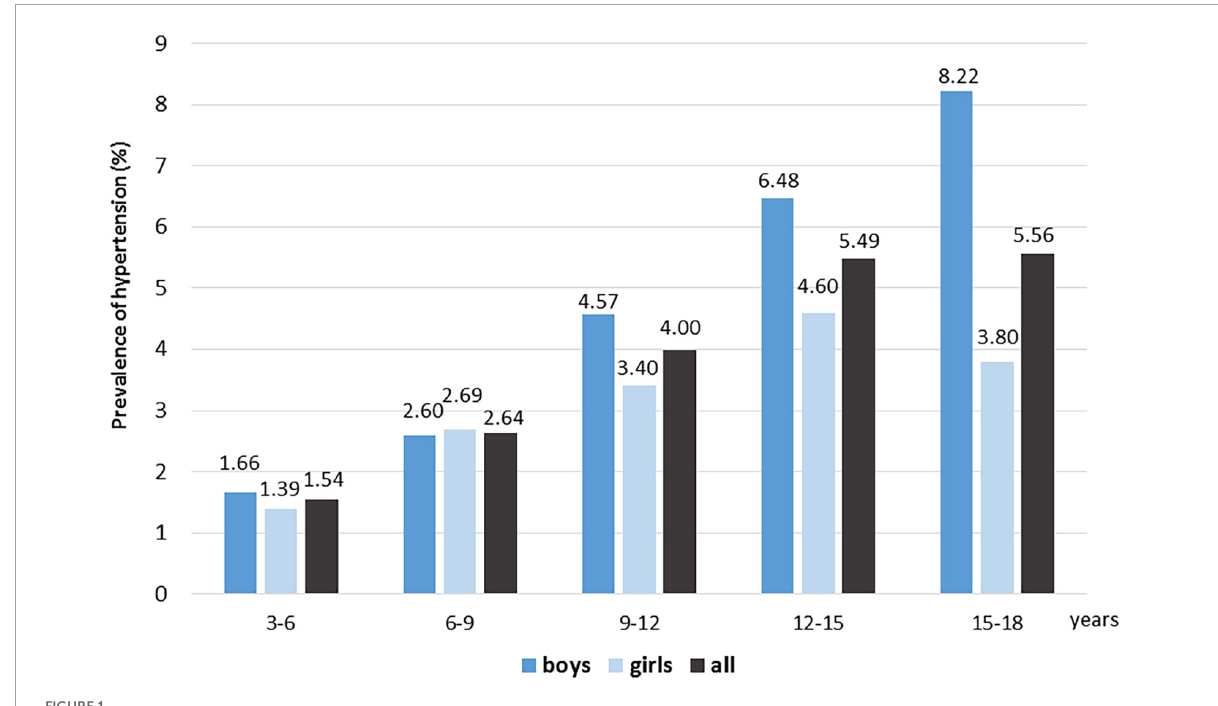
FIGURE1 Prevalence of hypertension in different age and gender